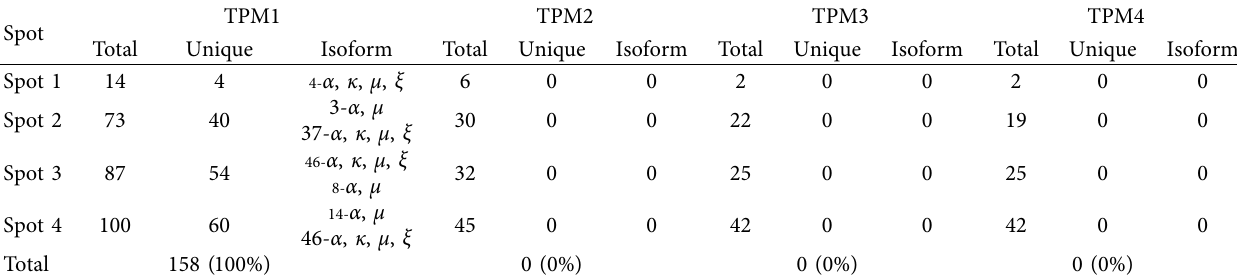
Table 4: Tropomyosin peptides identifed in adult monkey heart